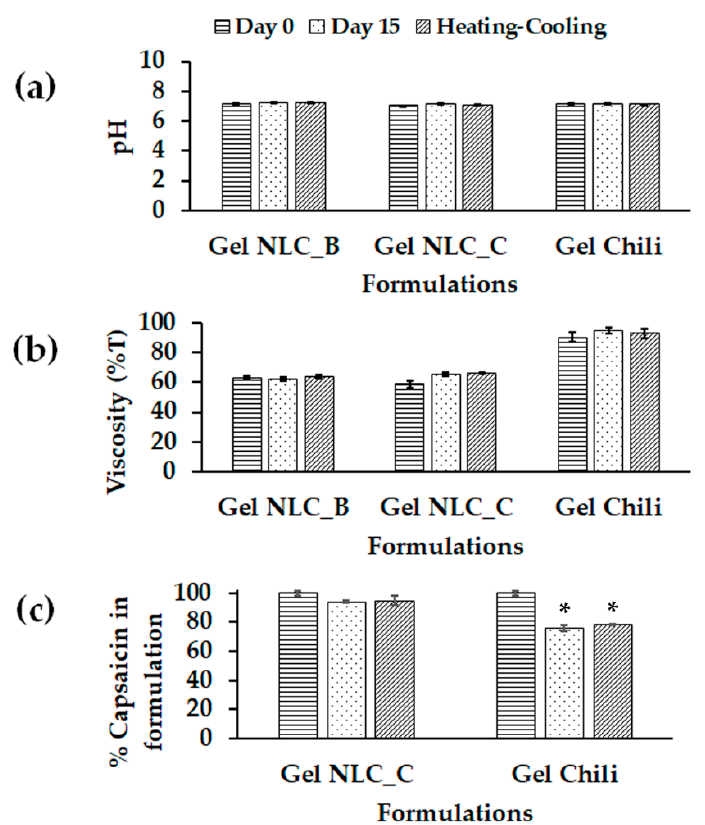
Figure 4. Stability study data of gel formulations: ( a ) pH, ( b ) viscosity, and ( c ) remaining capsaicin content in gel formulations after storage at room temperature and accelerated conditions. Abbreviations: